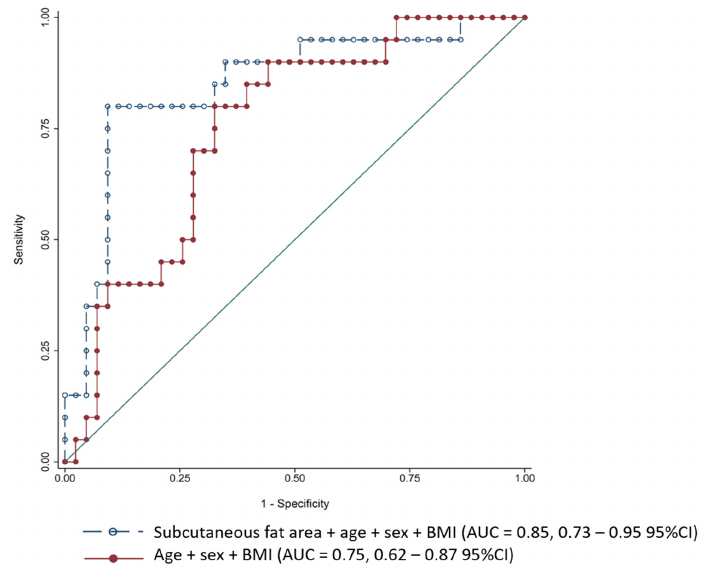
Figure 2. Receiver operating characteristic (ROC) curves for mortality prediction. Abbreviations: BMI = body mass index; AUC = area under the receiver operating characteristic curve; CI = confi- dence interval.